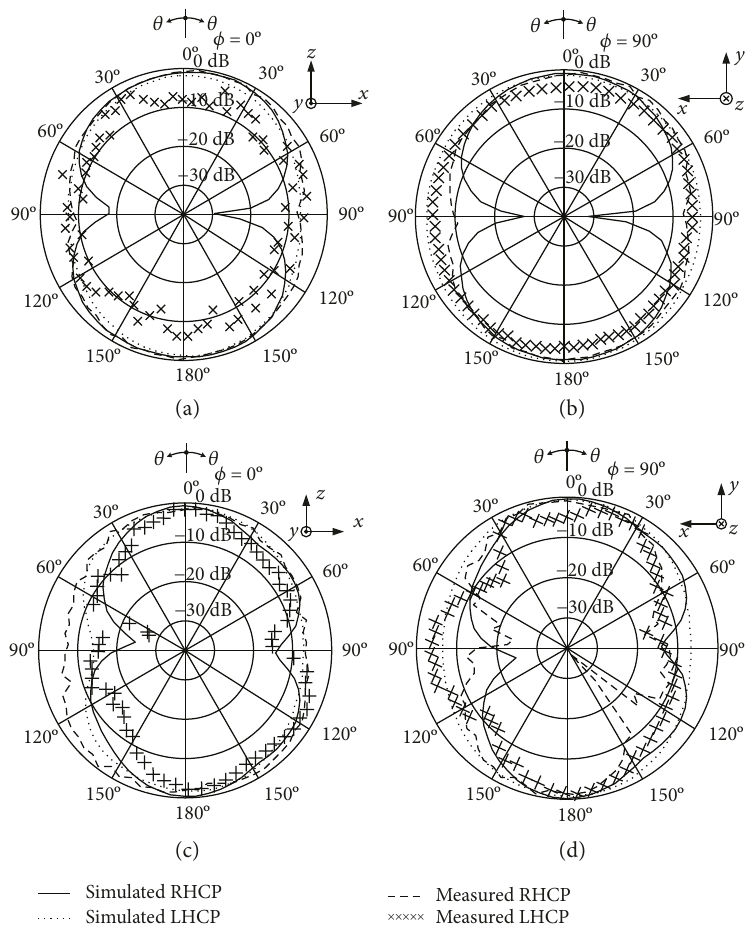
Figure 18: The simulated and experimental radiation patterns: (a) 2.45GHz at ϕ =0 ° , (b) 2.45GHz at ϕ =90 ° , (c) 5.8GHz at ϕ =0 ° , (d) and 5.8GHz at ϕ =90 °